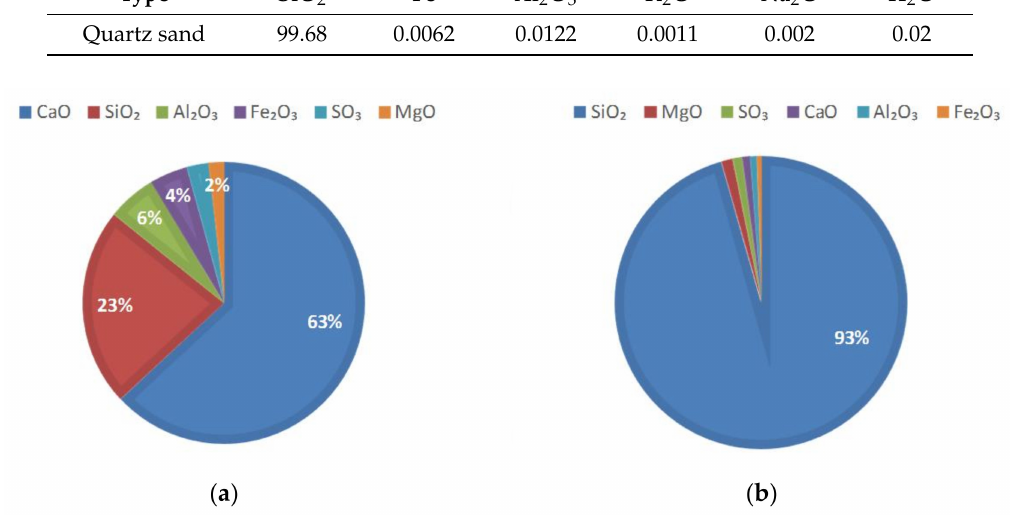
Figure 3. Chemical composition of cementing materials: ( a ) Cement; ( b ) Silica fume.